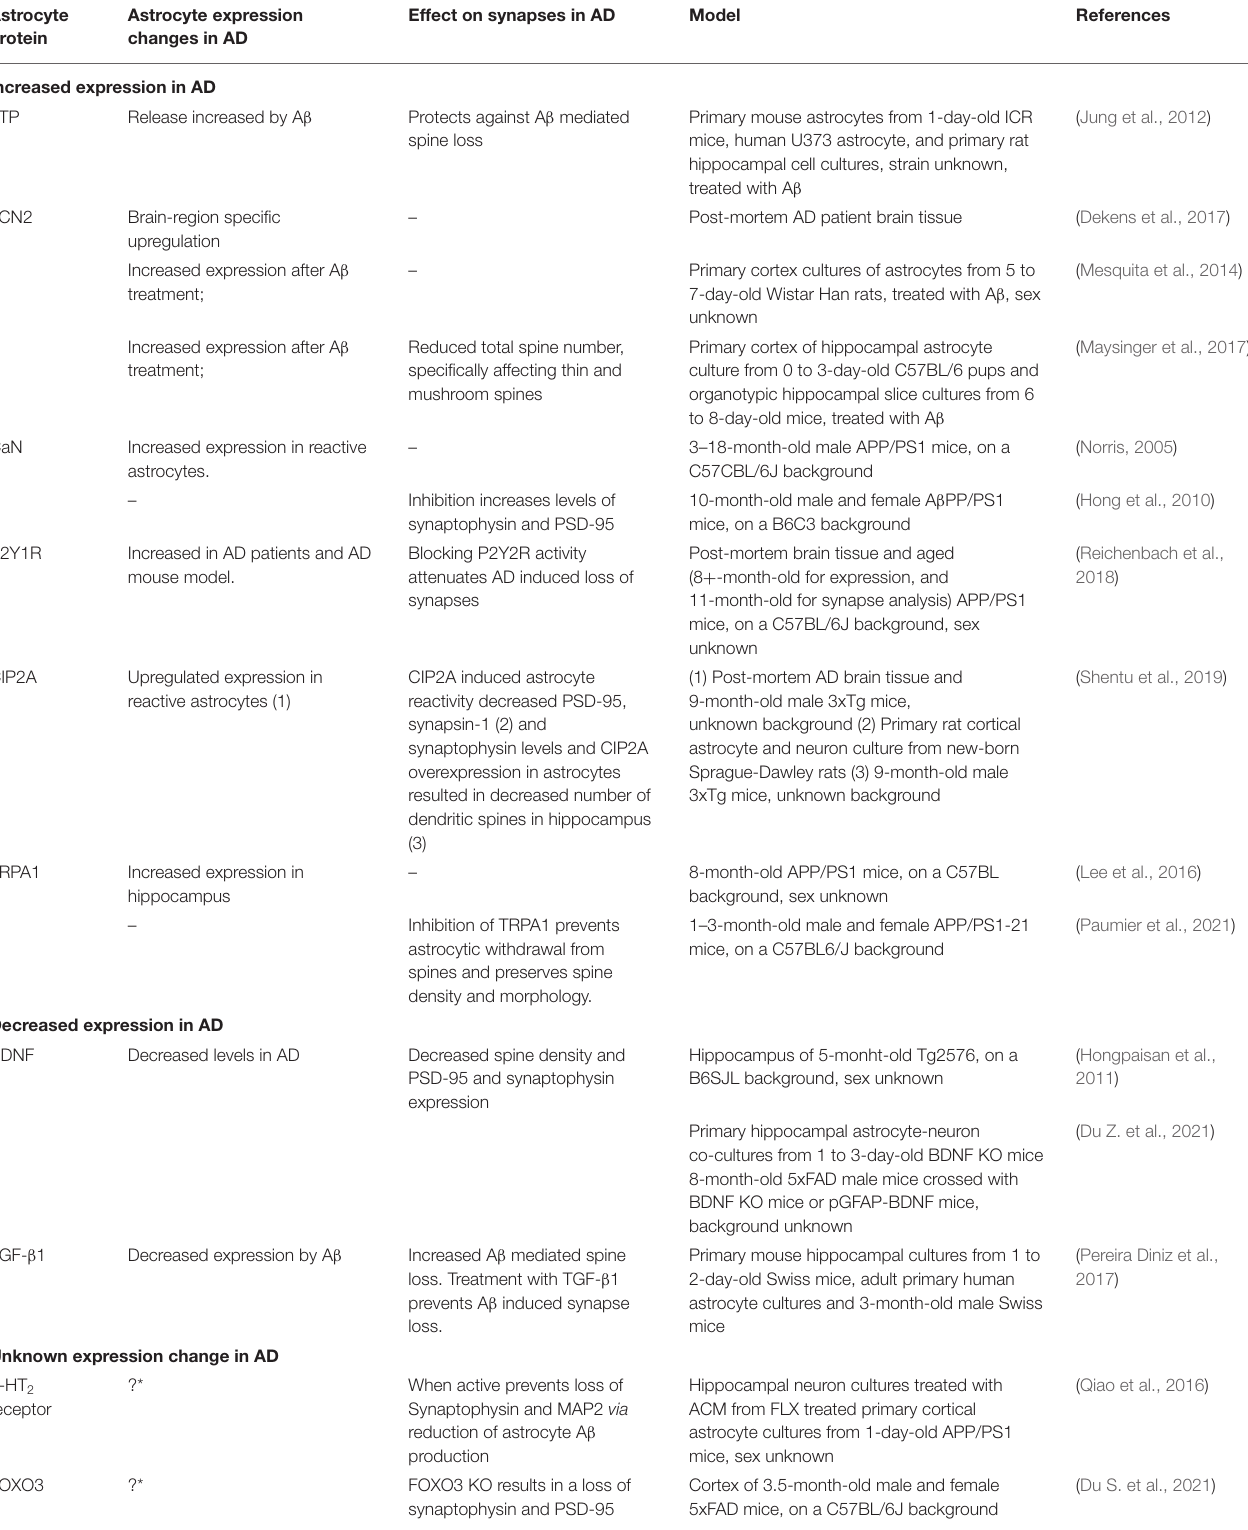
TABLE 2 | Increased and downregulated astrocyte proteins that affect synapse